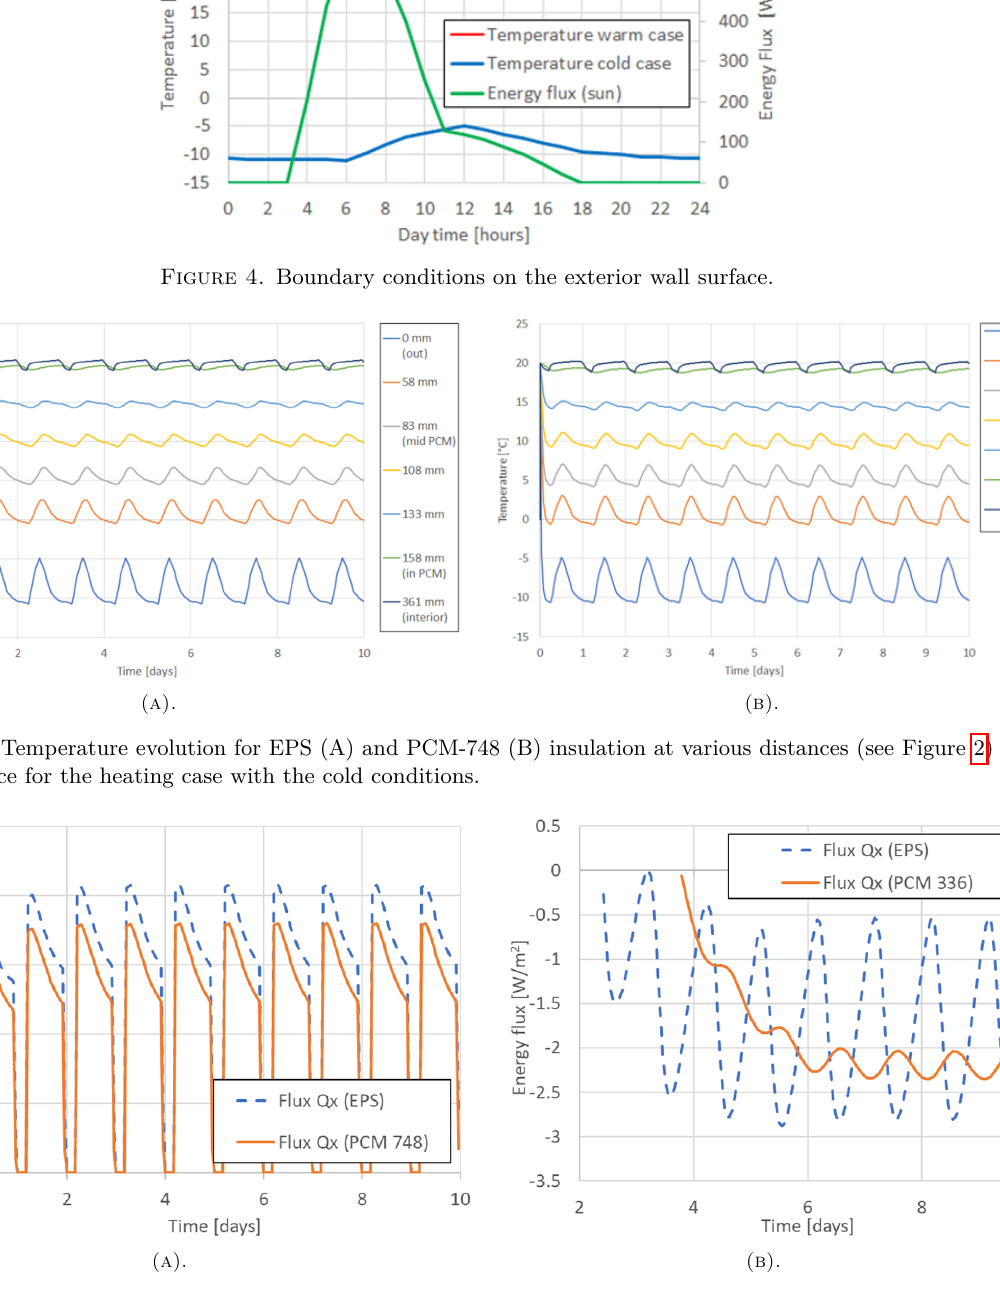
Figure 6. Comparison of energy flux on the interior heated surface for EPS and PCM-748 material for the cold case with heating and PCM-336 material for the warm case with